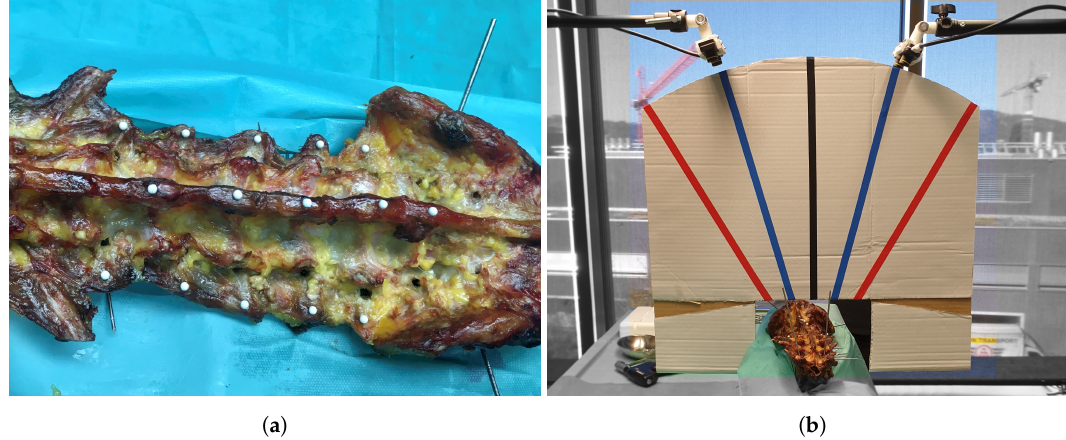
Figure 4. Setup for target registration error (TRE). ( a ) TRE were determined by push-pins, detectable in RGB-D frames and postoperative CT, inserted into both transverse processes and the spinous process of levels L1–L5. ( b ) Custom-made cardboard rule to set up standardized TRE viewpoints for RGB-D sensors at 0° (black), ± 15° (blue) and ± 30°